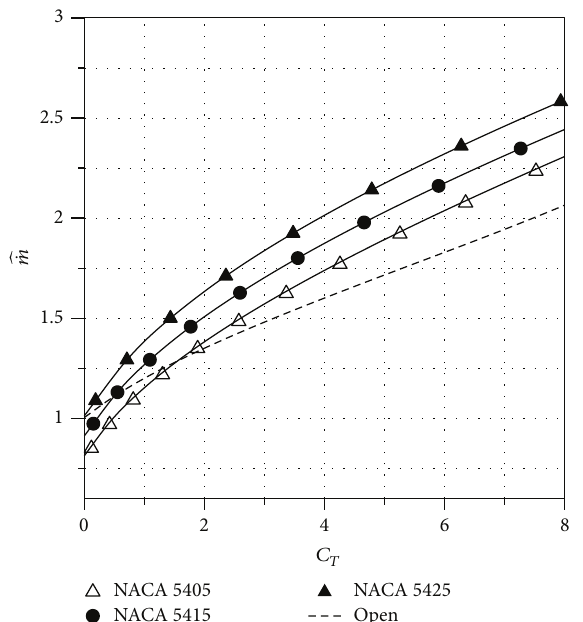
Figure 5: Effects of the profile thickness on the mass flow swallowed by the rotor.